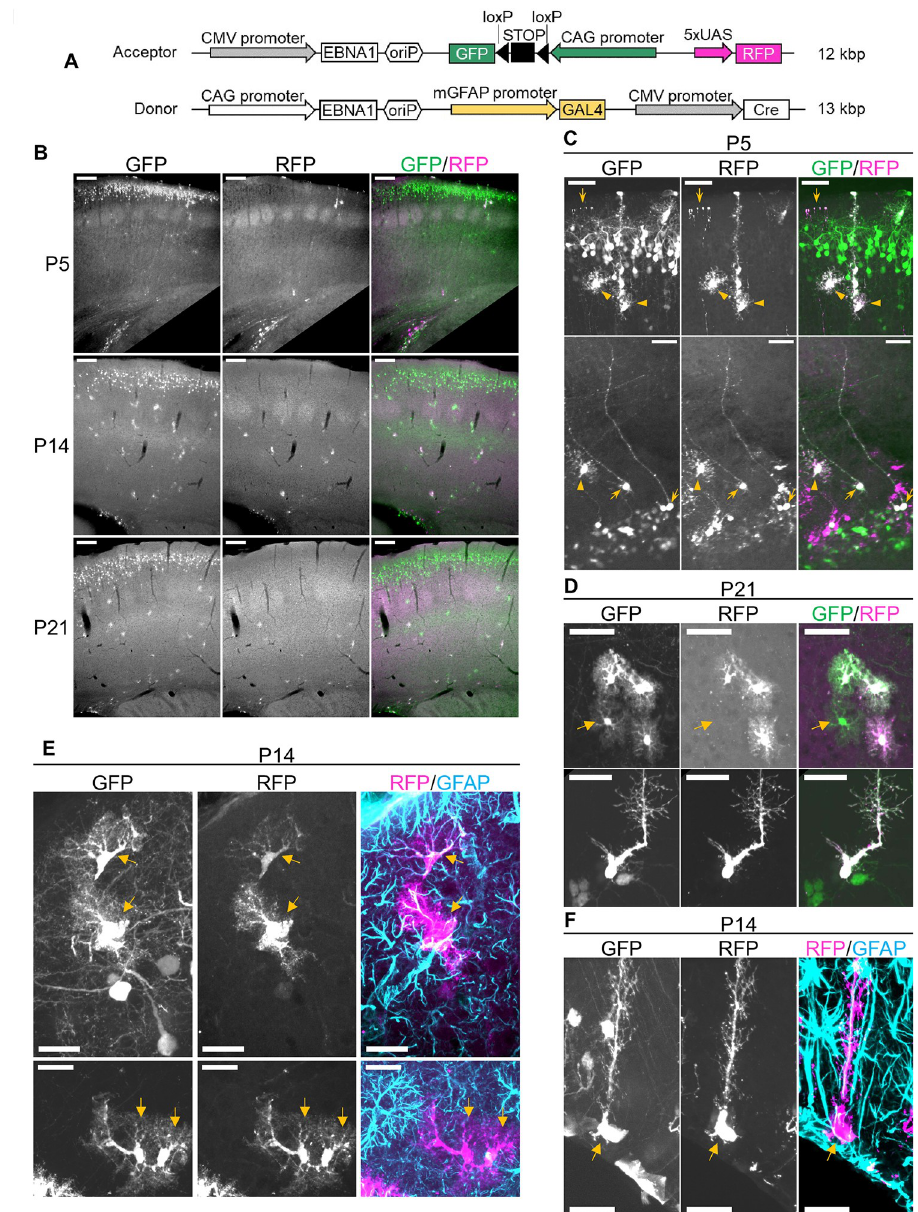
Fig 6. Conditional transgene expression by the EB-oriP plasmid is possible in combination with cell type-selective promoter. (A) Schematic illustration of the constructed plasmids named Acceptor and Donor. These were co- transfected by IUE at E15 and the brains were analyzed at P5, P14, and P21. Acceptor encodes GFP and RFP. The GFP expression driven by the ubiquitous CAG promoter requires excision of the loxP-flanked STOP sequence by Cre, and the RFP expression is driven by 5xUAS. Donor encodes Cre and GAL4-VP16, which activate transcription from 5xUAS. The Cre expression is driven by CMV promoter, while the GAL4-VP16 expression is driven by mGFAP promoter. Thus, GFP is expressed only in the cells co-transfected with both plasmids. Furthermore, RFP is expressed in the GFP-labeled cells in which the mGFAP promoter is active. (B) Fluorescence images of GFP and RFP of coronal sections from transfected brains at the indicated age. Scale bars: 200 μ m. (C) Representative images of GFP- and RFP- labeled cells at P5. Doubly labeled cells appeared to be astrocytes in the superficial region (C, upper) and V-SVZ (C, lower) is indicated by arrowheads. Doubly labeled cell appeared to be radial glia (C, lower) and its endfeet (C, upper) are indicated by arrows. Scale bars: 50 μ m. (D) Representative images of GFP- and RFP-labeled cells at P21. Either doubly labeled or only GFP-labeled astrocytes (indicated by arrow) in cortex (upper). Doubly labeled cell appeared to be a B1 cell in V-SVZ (lower). (E and F) GFP- and RFP-labeled cells at P14 and immunostaining for GFAP.